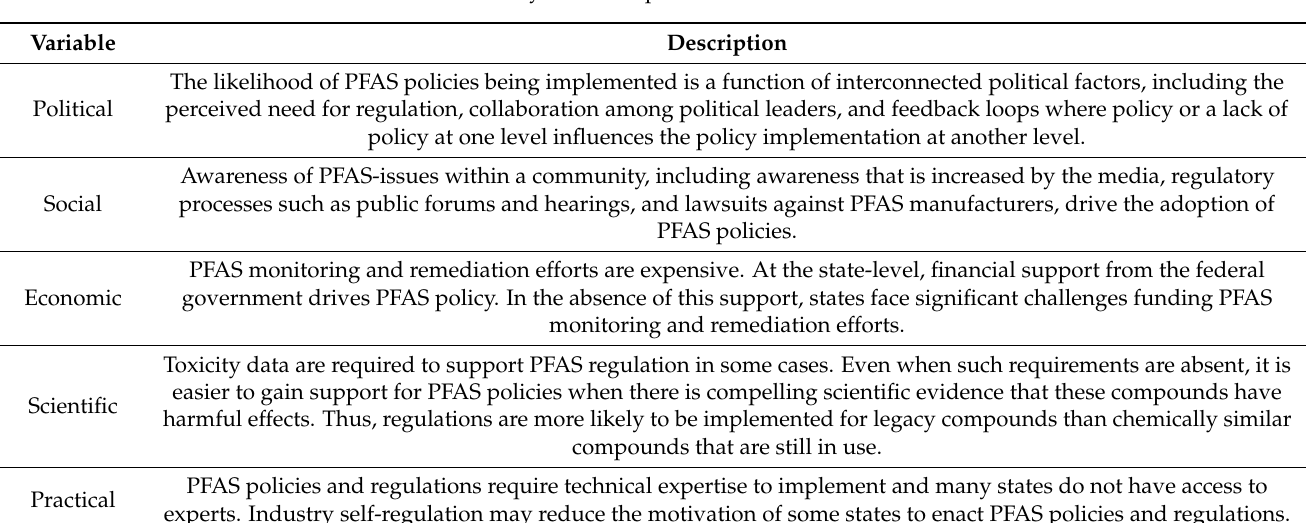
Table 3. Policy themes captured in literature